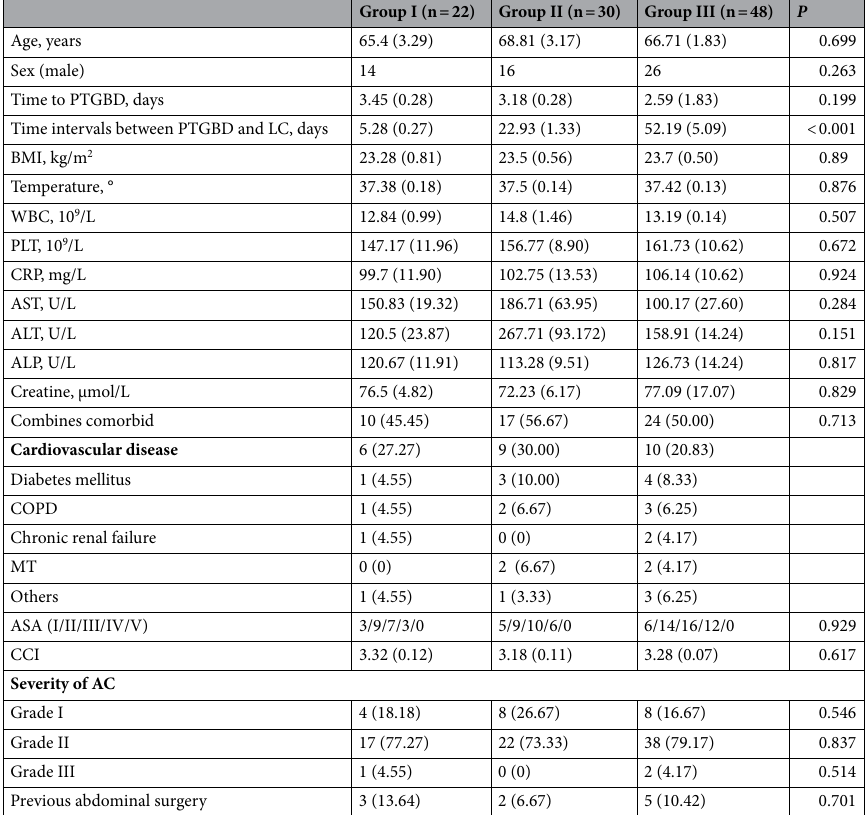
Table 1. The baseline characteristics of included patients. Values were presented as mean ± SEM or n (%). LC laparoscopic cholecystectomy, PTGBD percutaneous transhepatic gallbladder drainage, BMI body mass index, WBC white blood cell, PLT blood platelet, CRP C-reactive protein, AST aspartate aminotransferase, ALT alanine aminotransferase, ALP alkaline phosphatase, COPD chronic obstructive lung disease, MT malignant tumor, ASA American Society of Anesthesiologist, CCI Charlson Comorbidity Index.